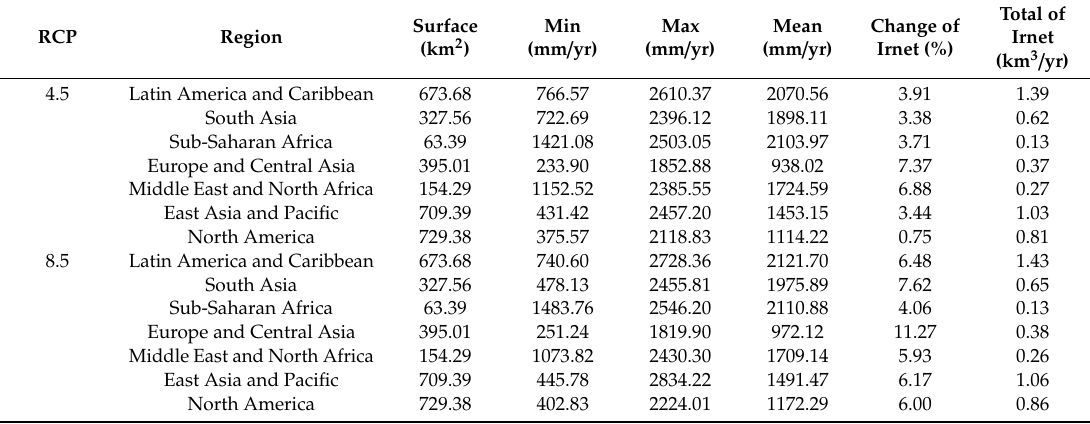
Table 4. GFDL regional net irrigation water requirement.